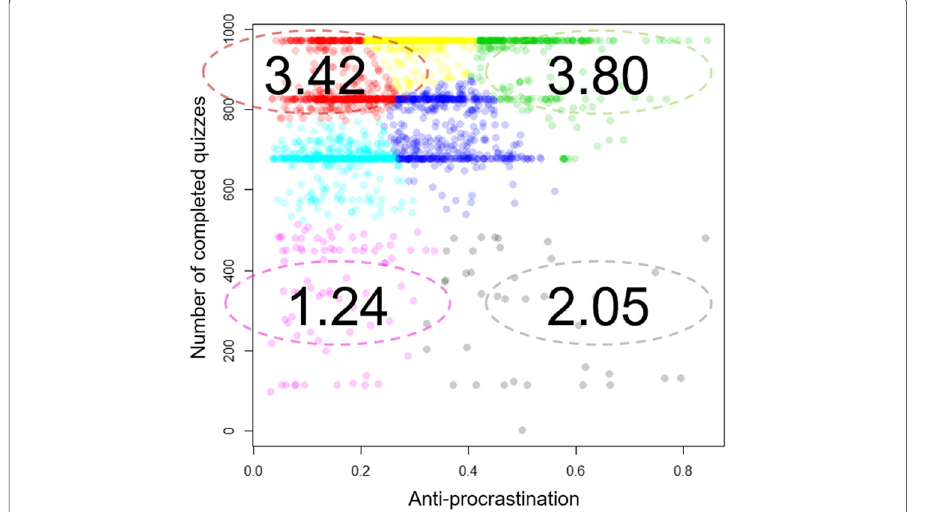
Fig. 3 Cluster distributions for learning pace and the final course point average of four